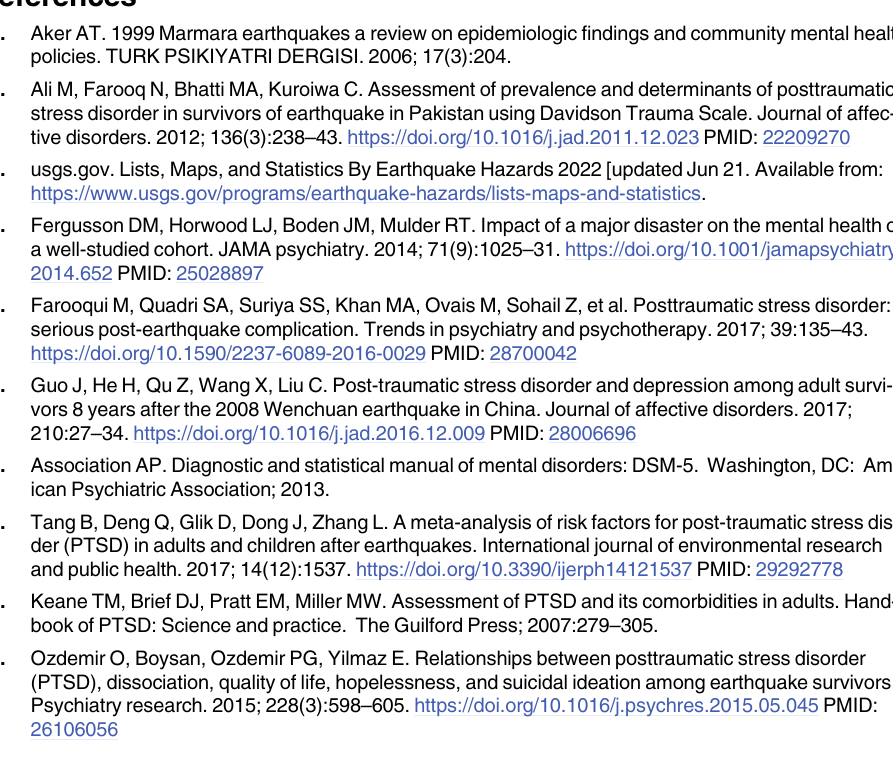
S1 Table. Search terms used in each database. S2 Table. Central characteristics of existing psychological therapies for PTSD. S3 Table. PRISMA-P (Preferred Reporting Items for Systematic review and Meta-Analysis Protocols) 2015 checklist: Recommended items to address in a systematic review